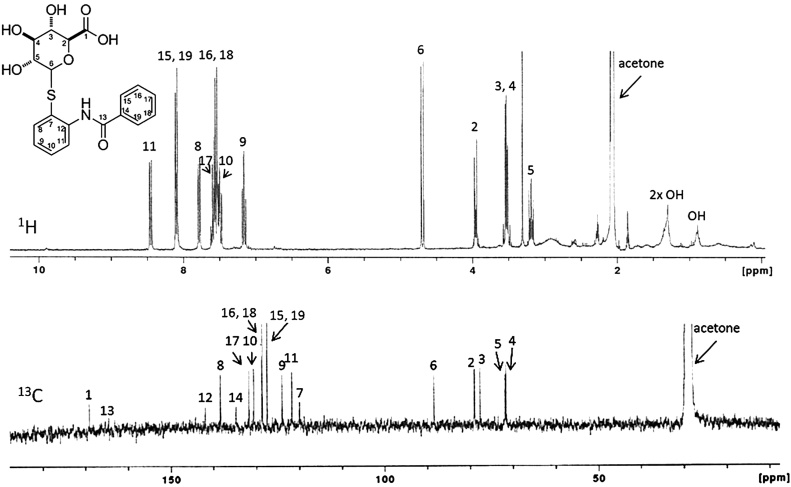
1H and 13C NMR spectra and signal assignments of urinary metabolite M6.